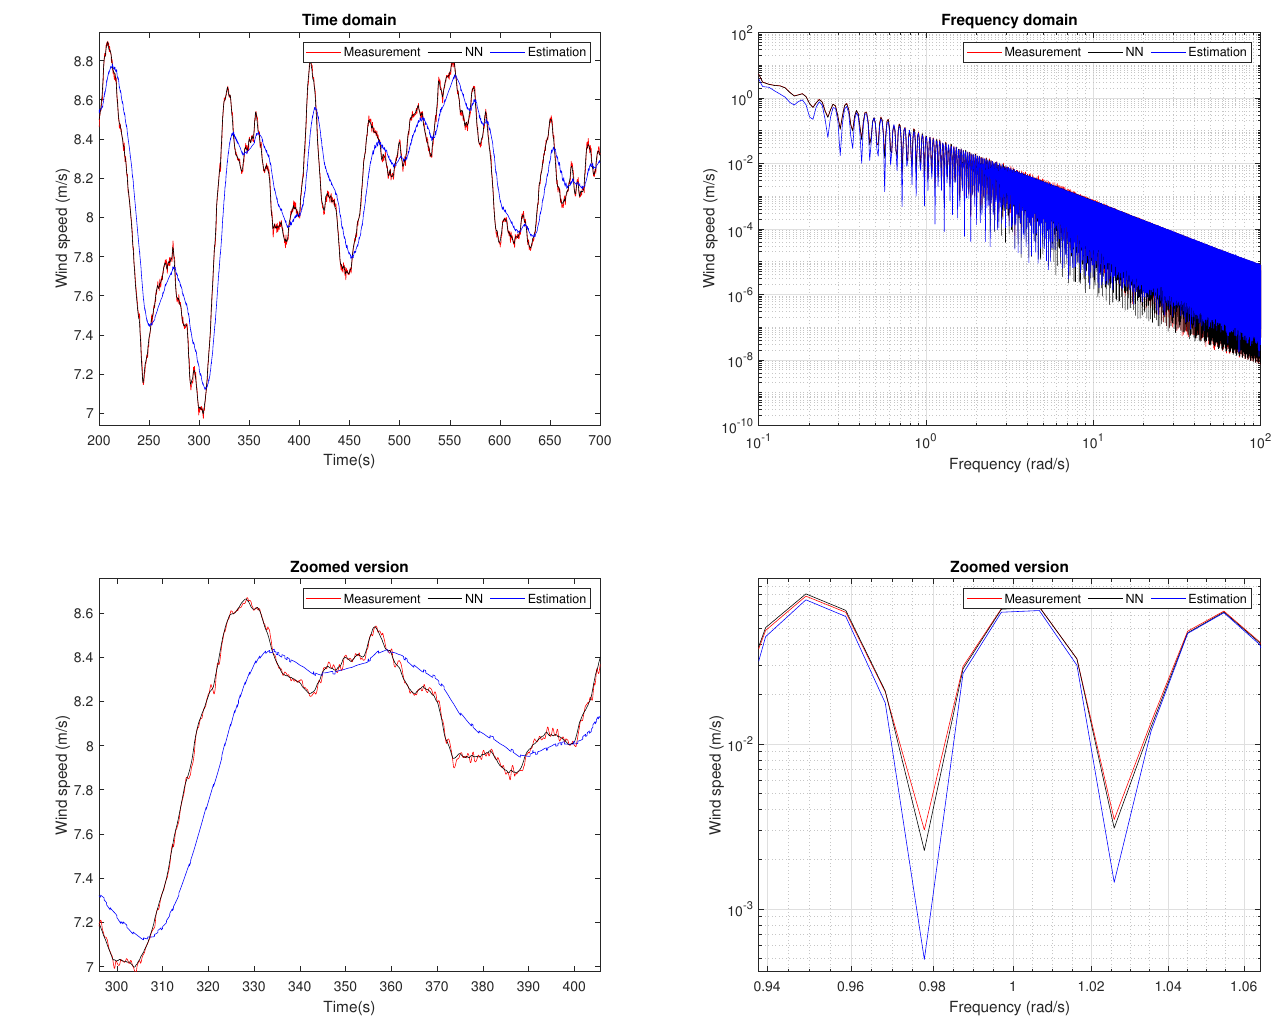
Figure 15. Scenario 5: Wind speed estimation from Turbine